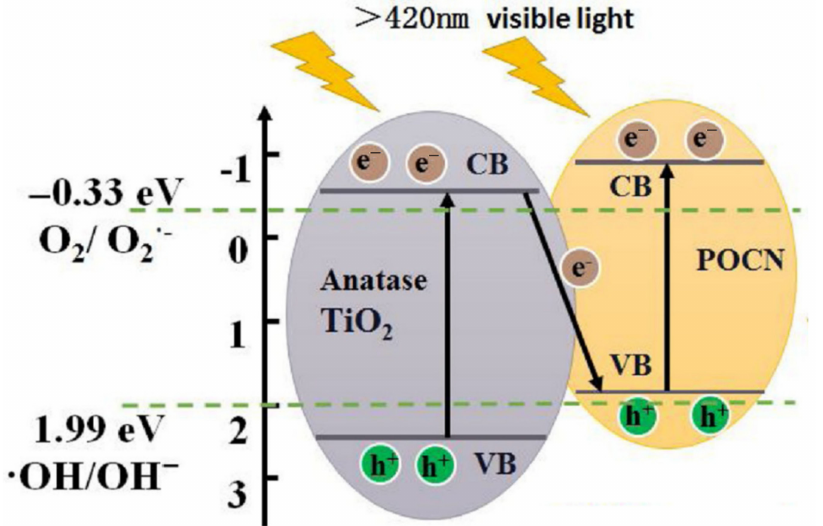
Figure 17. The mechanism of P, O-GCN/TiO 2 photocatalyst under visible light irradiation. Repro- duced with permission from Ref. [99].